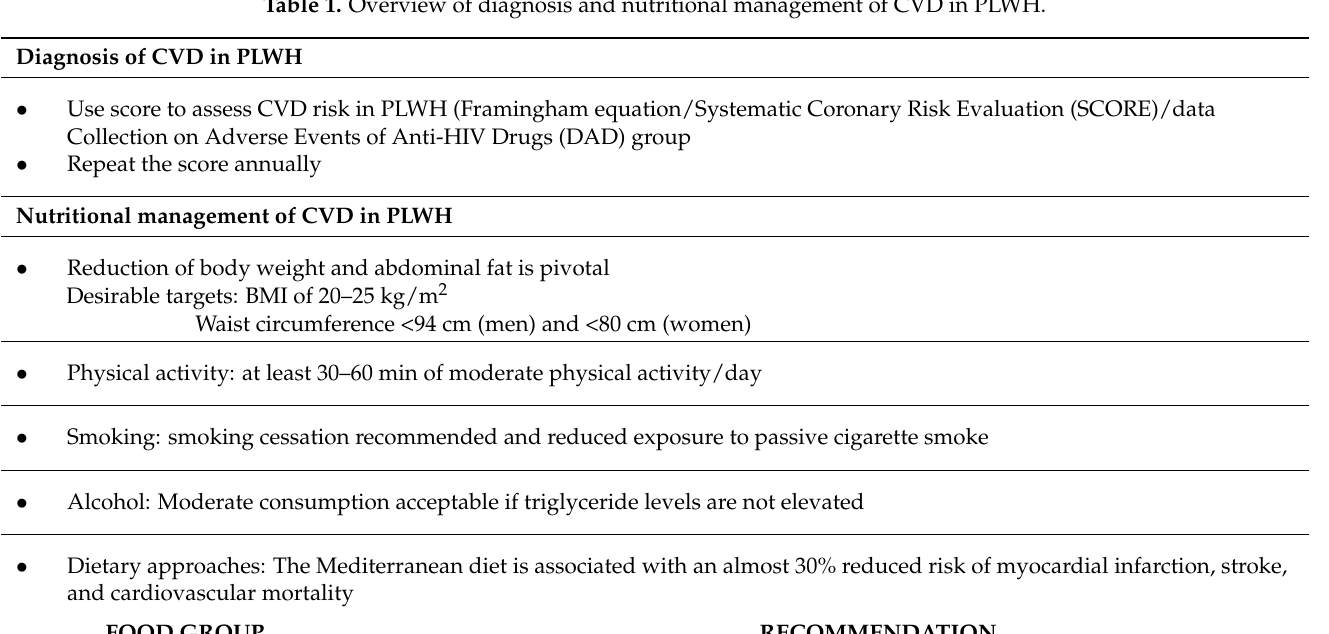
Table 1. Overview of diagnosis and nutritional management of CVD in